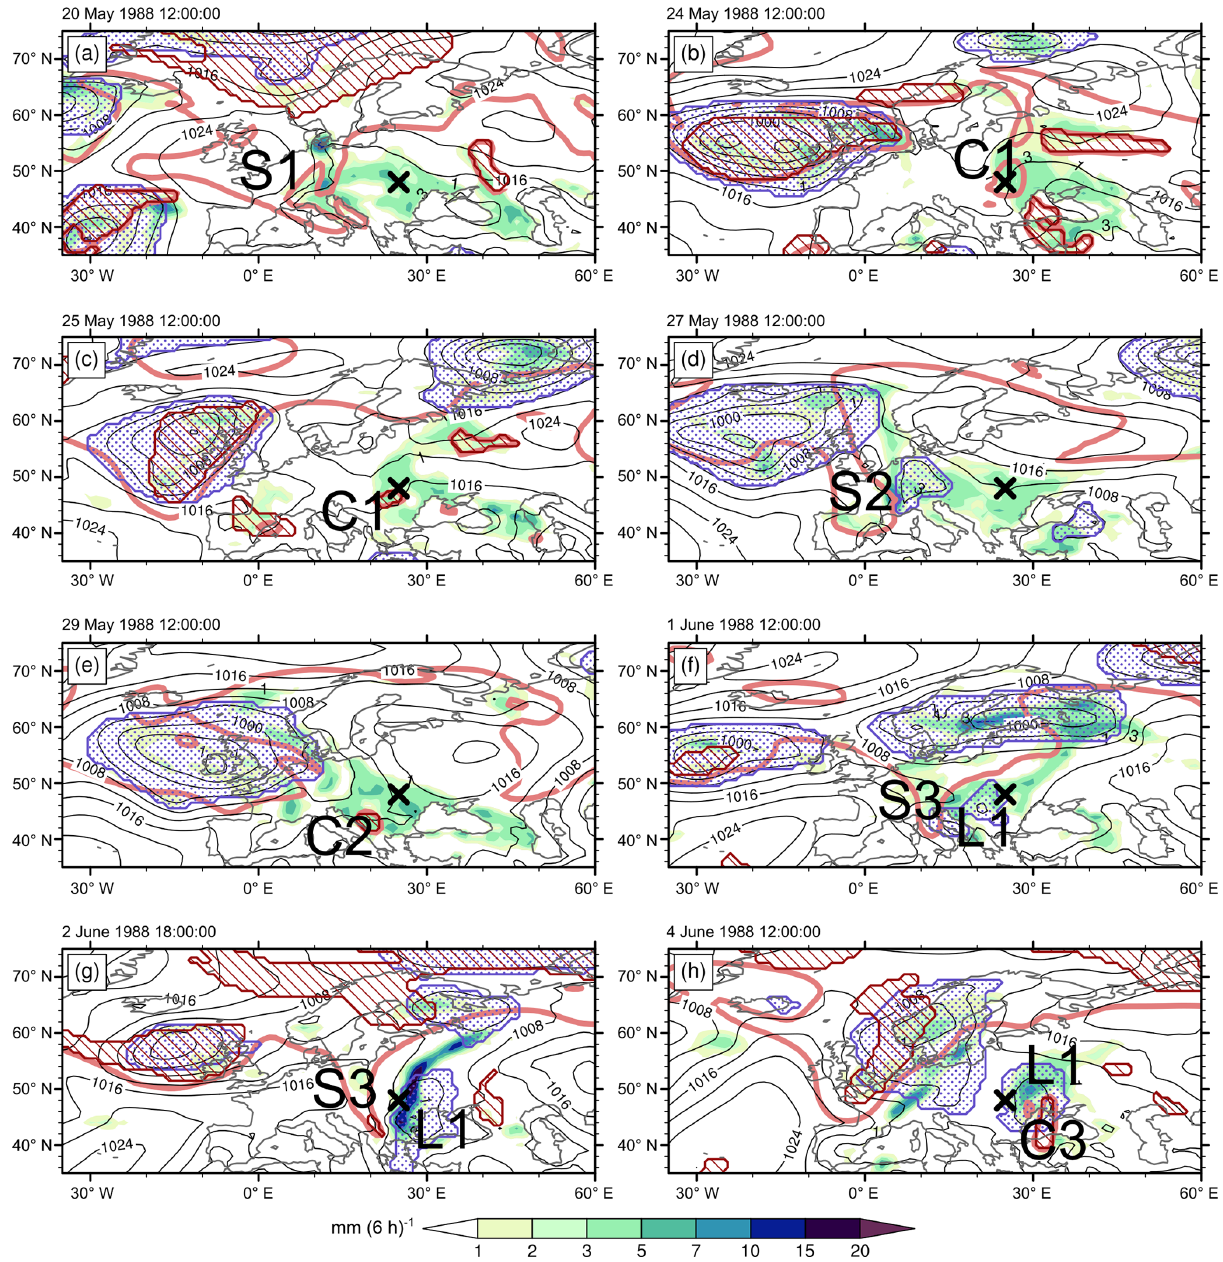
Figure 6. As Fig. 3 but for the longest wet spell at 48 ◦ N, 25 ◦ E in Romania ( S 1 (48 ◦ N, 25 ◦ E)). The light red lines depict 2PVU at 320K. The valid time of each panel is shown in the top